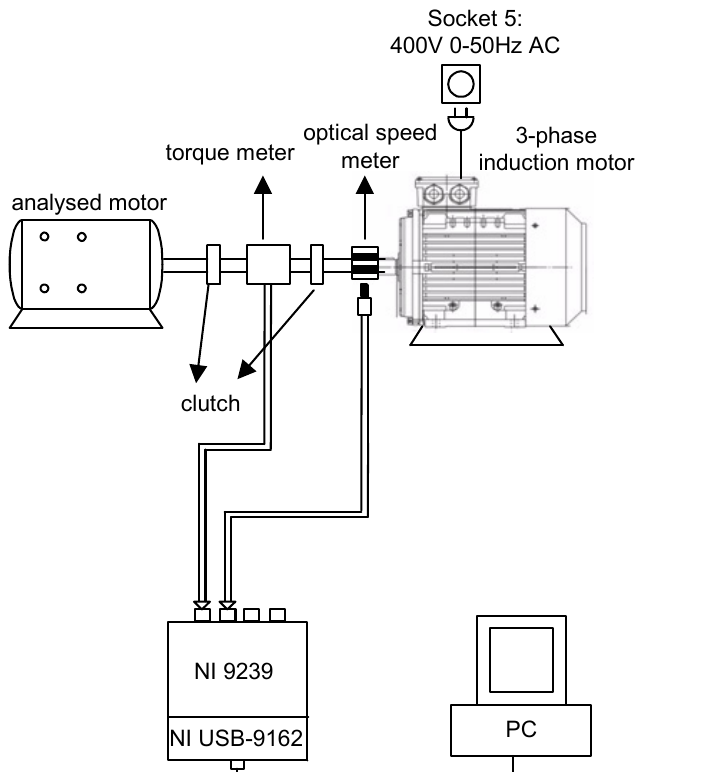
Figure 14. Experimental setup for the measurement of the braking torque on the rotor of an electric motor.